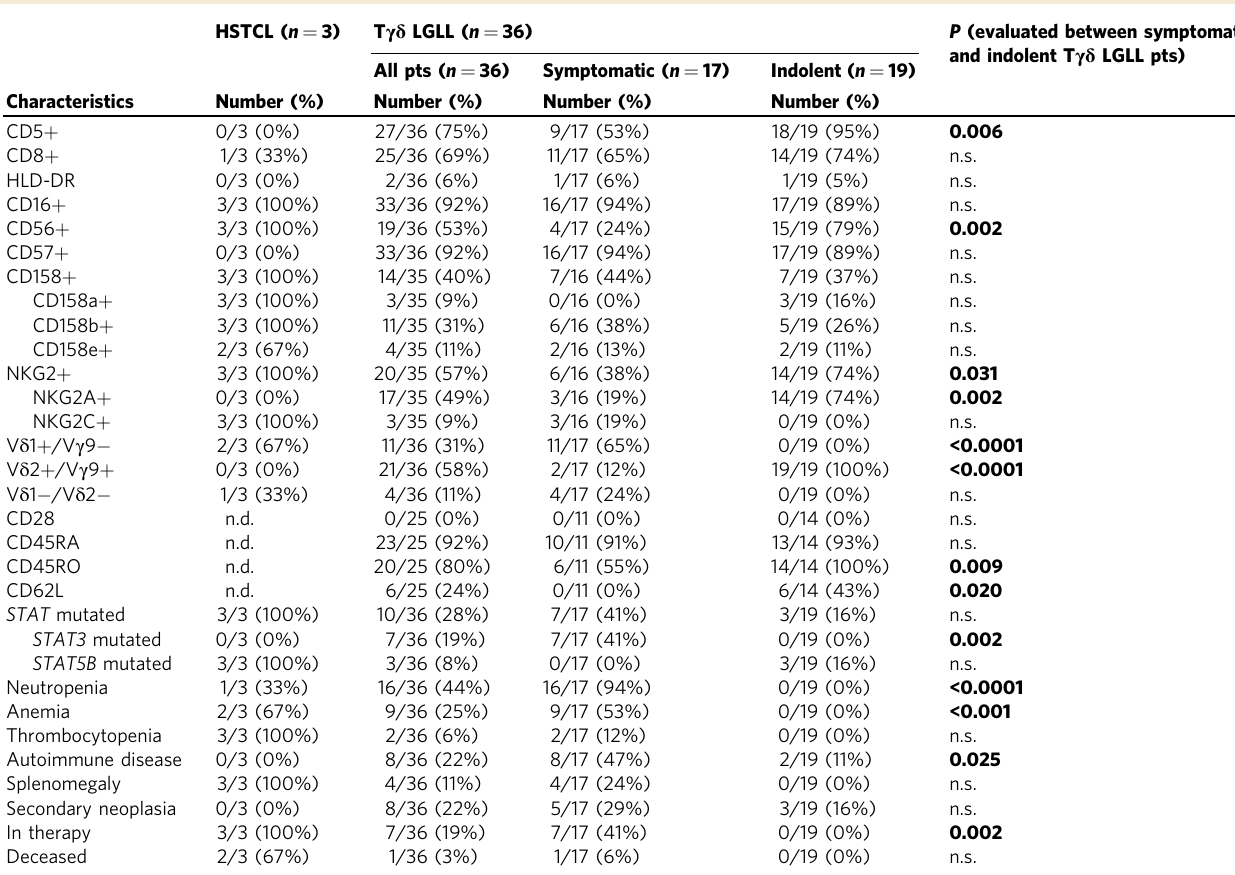
Table 2 Data about the incidence of immunophenotypic, STAT mutational, and clinical features in the patients distinguished between HSTCL and T γδ LGLL (total, symptomatic and asymptomatic